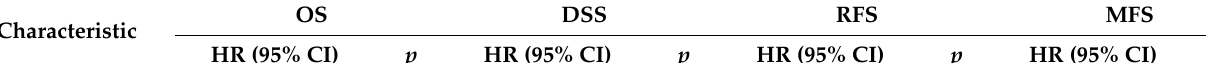
Table 2. Multivariate COX regression analysis of survival